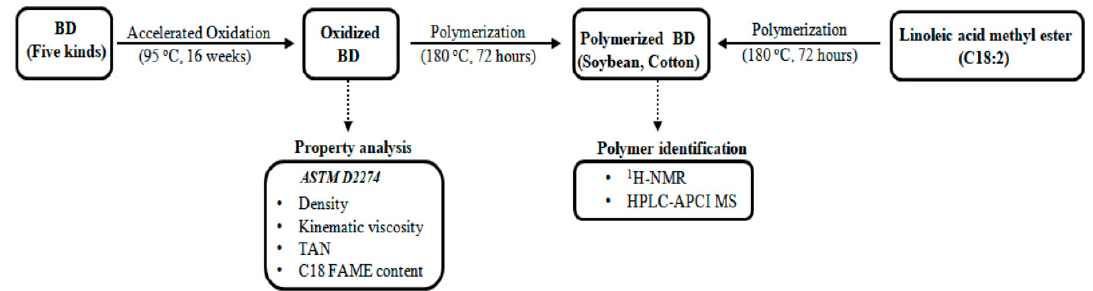
Figure 2. Experimental procedure for the accelerated oxidation and polymerization of biodiesel (BD) and linoleic acid methyl esters and product analysis methods.